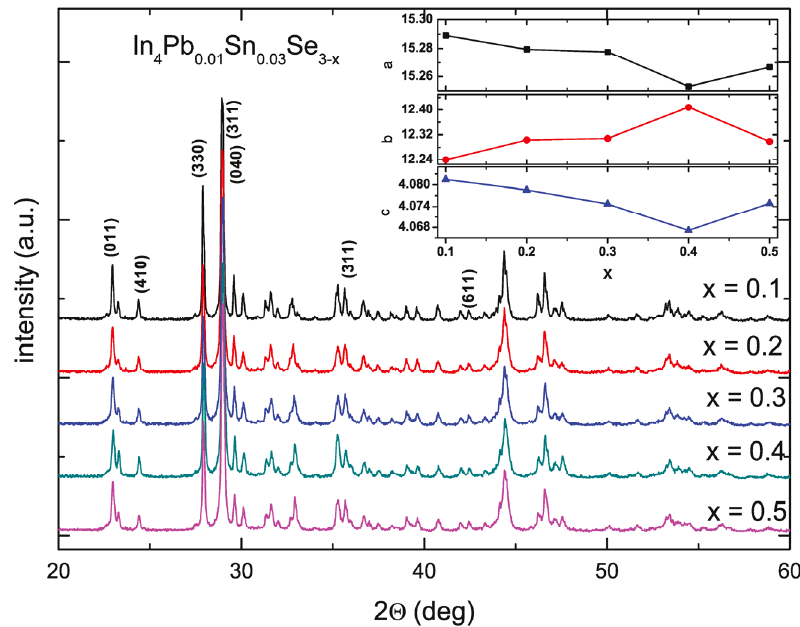
Figure 19. The powder X-ray diffraction patterns of In 4 Pb 0.01 Sn 0.03 Se 3 − x ( x = 0.1, 0.2, 0.3, 0.4, and 0.5) polycrystalline compounds. The inset shows the lattice parameters of the compounds. Reproduced with permission from Elsevier B.V., 2014 [43]. The temperature dependent electrical resistivities ρ (T) of polycrystalline compounds In 4 Pb 0.01 Sn 0.03 Se 3 − x ( x = 0.1, 0.2, 0.3, 0.4, and 0.5) [43] and In 4 Se 2.9 (open square for comparison [21]) are presented in Figure 20a. The ρ (T) of Pb-/Sn-codoped polycrystalline compound In 4 Pb 0.01 Sn 0.03 Se 2.9 is significantly decreased than the one of In 4 Se 2.9 . The ρ (T) s near room temperature of Pb-/Sn-codoped and Se-deficient polycrystalline compounds are decreased with increasing Se-deficiency except for x = 0.5 case. The decrease of electrical resistivity is similar to those of In 4 Se 3 − x polycrystalline compounds [21,40,41,44]. From the effective carrier concentration n H and Hall mobility μ H , calculated by Hall resistivity ρ xy measurement (Table 8), the carrier concentrations are increased with increasing Se-deficiency while electrical resistivity and Hall mobility of the compounds are decreased up to x = 0.4. The Pb-/Sn-codoping significantly increase the carrier density from 2.09 × 10 17 cm − 3 for polycrystalline compounds of In 4 Se 2.9 [21] to 2.67 × 10 18 cm − 3 for In 4 Pb 0.01 Sn 0.03 Se 2.9